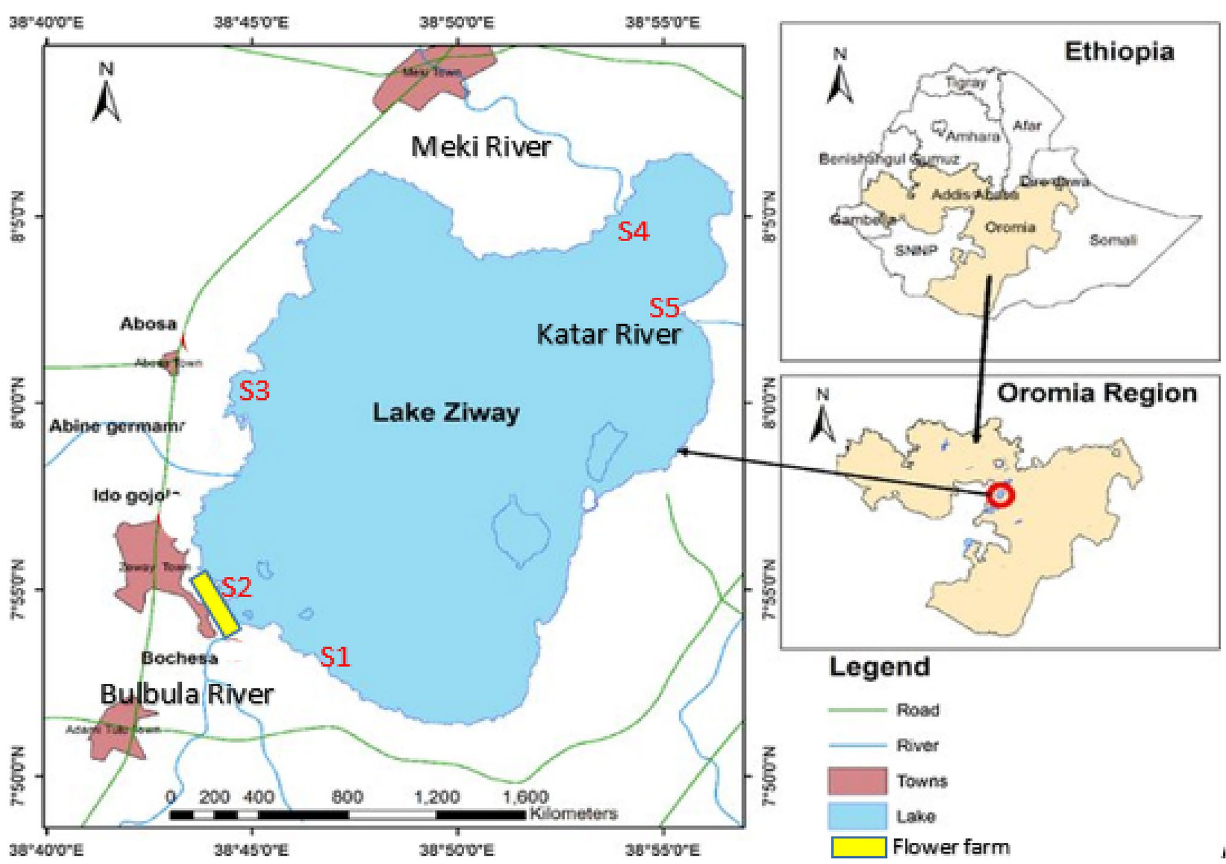
Fig. 1 Map of Lake Ziway showing sampling sites ( adapted from Girma et al. [25])